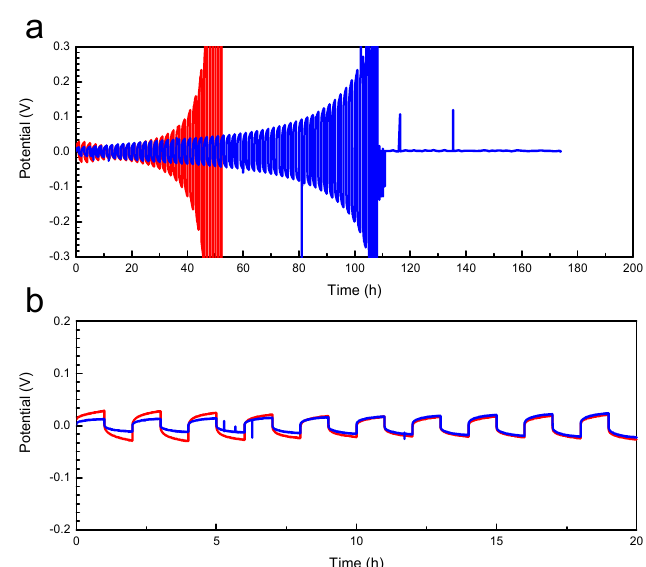
Figure 2. Galvanostatic cycling of SPE-1. ( a ) Data of the best (blue) and worst (red) performing cells show stable cycling up to 20 and 50 cycles (40 h and 100 h, respectively) before a significant overpotential develops. ( b ) Similar initial voltage response over one-hour half cycles. The tests were performed at 70 °C, with LiTFSI content corresponding to r = 0.08, in a symmetrical Li/SPE/Li cell with 1 h forward current followed by 1 h reverse current at 0.02 mA cm − 2 . The cyclic voltammetry data of Figure 3 show a relatively large voltage stability window (0–4.5 V) overall for SPE-1. However, the peaks in the 0.5–2 V vs. Li + /Li range show the presence of reduction processes, indicating a limited cathodic stability in this voltage range.